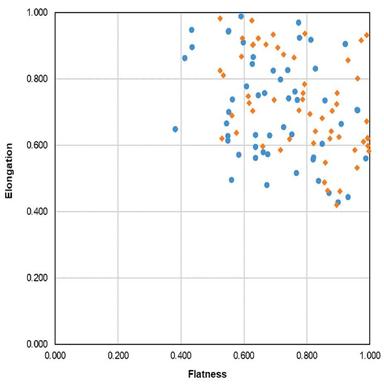
Visualization of the ballast morphology data plot: (a) fresh ballast, (b) used ballast, and (c) fresh and used ballast.